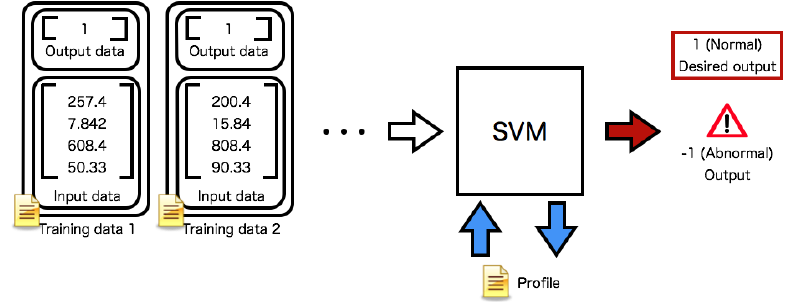
Figure 3. Training process of a profile between two sensors. The training data are input to an SVM. The SVM learns desired outputs from the training data set.